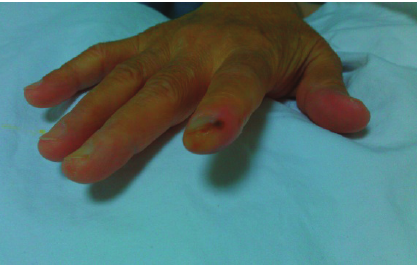
Figure 1: View of patient’s